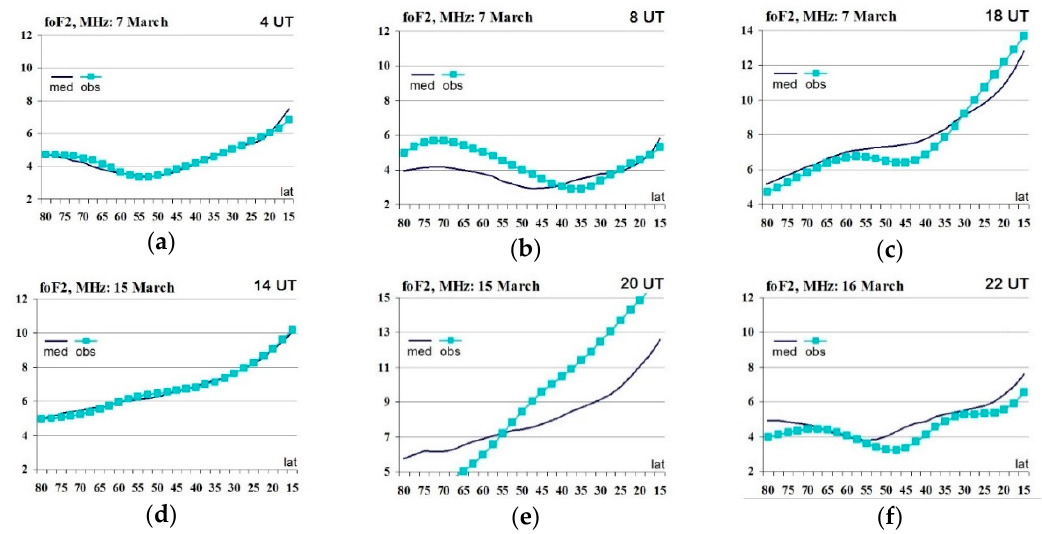
Figure 12. Examples of foF2 latitudinal dependence during quiet periods (blue curves) and during disturbances (emerald curves with rectangles): ( a ) 7 March (MP beginning), ( b ) 7 March (developed MP), ( c ) 7 March (developed RP), ( d ) 15 March (MP beginning), ( e ) 7 March (Dst minimum) and ( f ) 16 March (after RP).